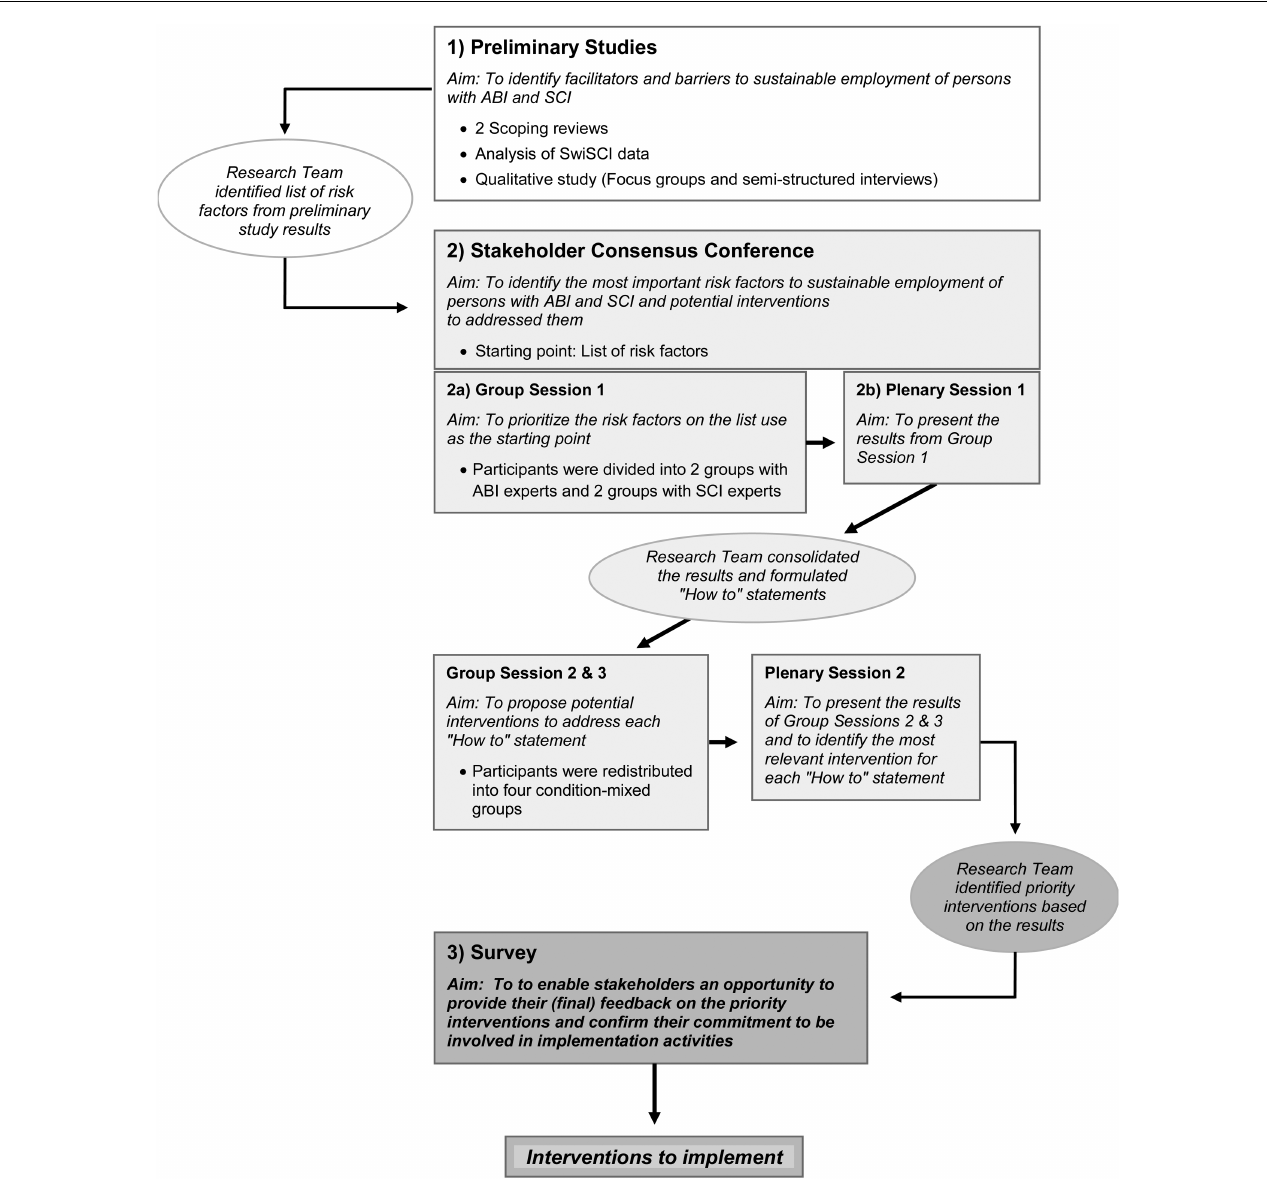
FIGURE 1 Consensus